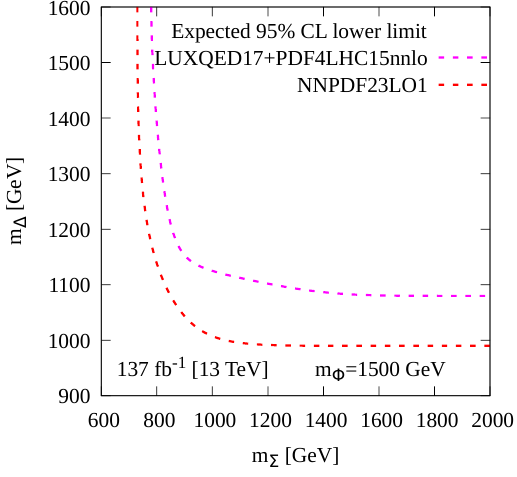
Figure 12 . 95% CL lower limit on m Σ – m ∆ for m Φ = 1500 GeV. Region below the dashed curves are